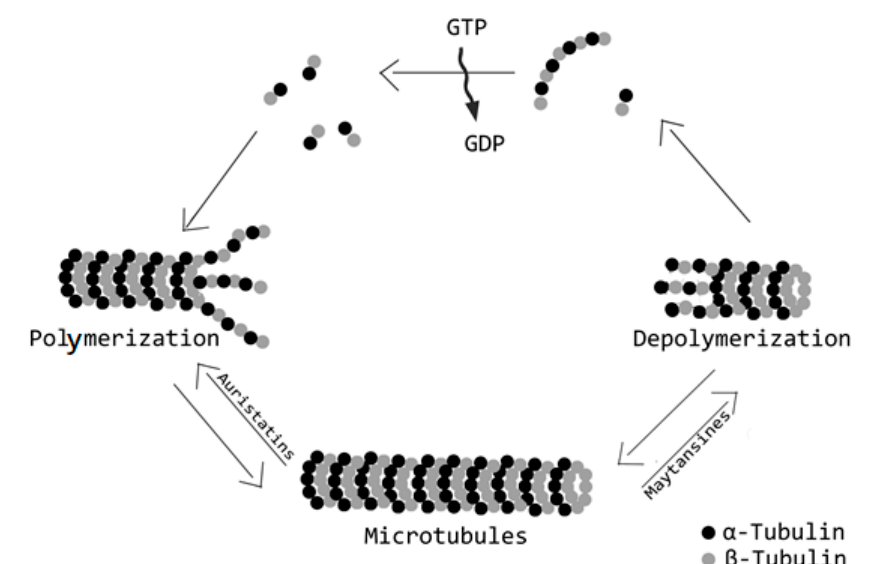
Figure 5. Mechanism of action of tubulin inhibitors payloads: polymerization promoters (microtubule stabilizers) and tubulin polymerization inhibitors (microtubule destabilizers). In the figure are two exemplifying drugs acting on microtubule formation: auristatins alters the formation of microtubules by binding on the β -subunit of α - β tubulin dimers; thus, producing uncontrolled growth of microtubules. Maytansines, on the contrary, stop tubulin dimers formation impairing the production of mature microtubules.